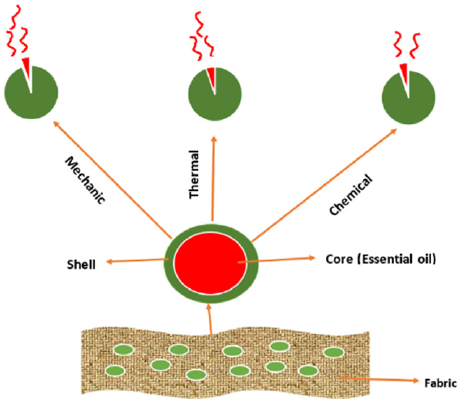
Figure 2. Slow-release mechanism of encapsulated essential oils in aromatherapeutic